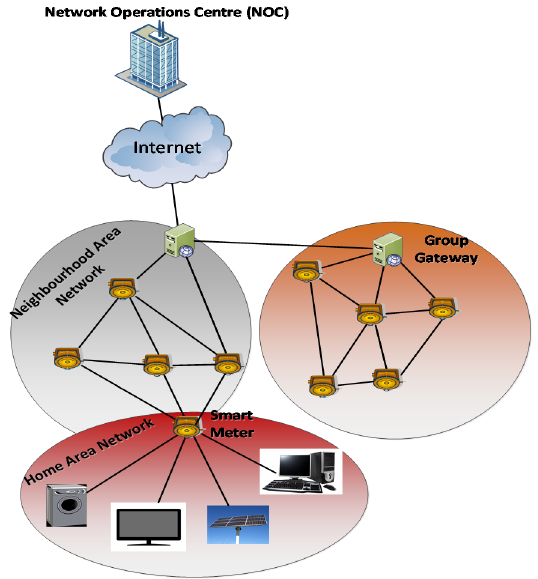
Figure 2. Smart Grid Network Model.